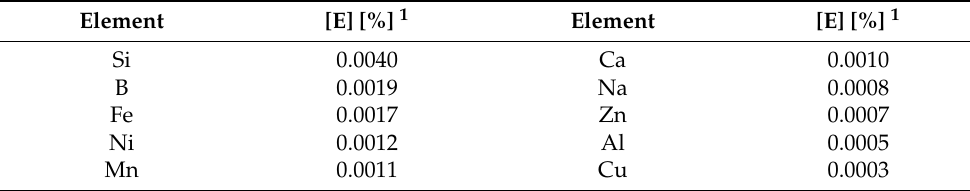
Table 5. CPI-MIP-OES results of impurities determined in batch III fraction III.